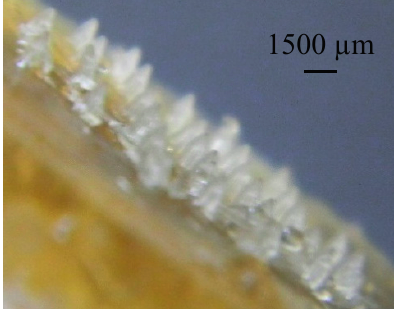
Figure 10. 1500 µm-long microneedle array formed from FSBP at 50 °C.